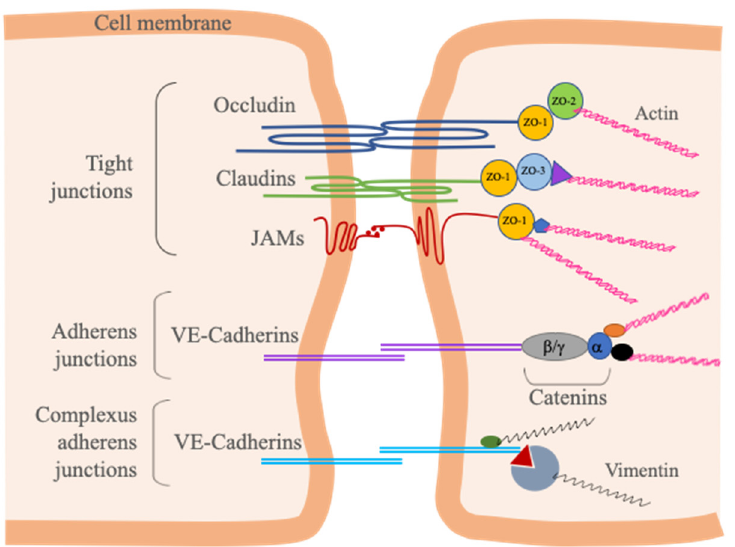
Figure 3. Major TJ and AJ proteins between adjacent BMECs. Transmembrane TJ proteins (Occludin, Claudins and JAMs) associate and bind to each other across the intercellular cleft. These proteins link to the F-actin cytoskeleton via zonula occludens proteins (ZO-1/2/3) and α -catenin. The most important component of BMEC AJs, VE-Cadherin, binds to the F-actin via catenins ( α -catenin, β -catenin, γ -catenin, p120-catenin) and vimentin. VE-Cadherin is also the component of complexus adherens junctions, and links to vimentin by desmosomal plakoglobin/desmoplakin or p0071 linker proteins.